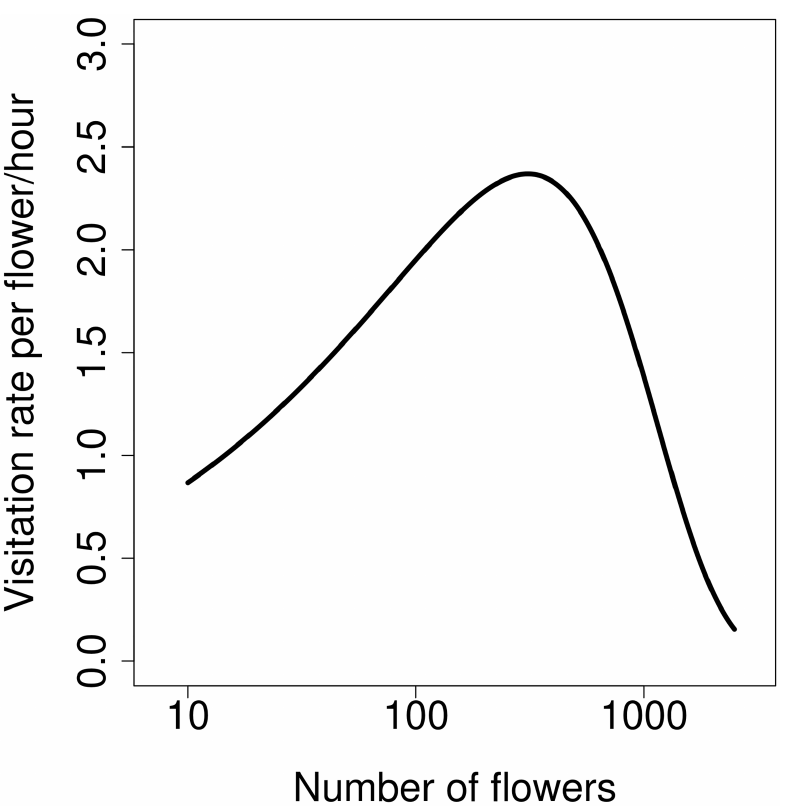
Fig 4. Flower visitation rate peaks at the intermediate number of flowers. Visitation rate per flower per hour was estimated as a product of the number of visitors (honeybees only) and the proportionof flowers visited by an individual